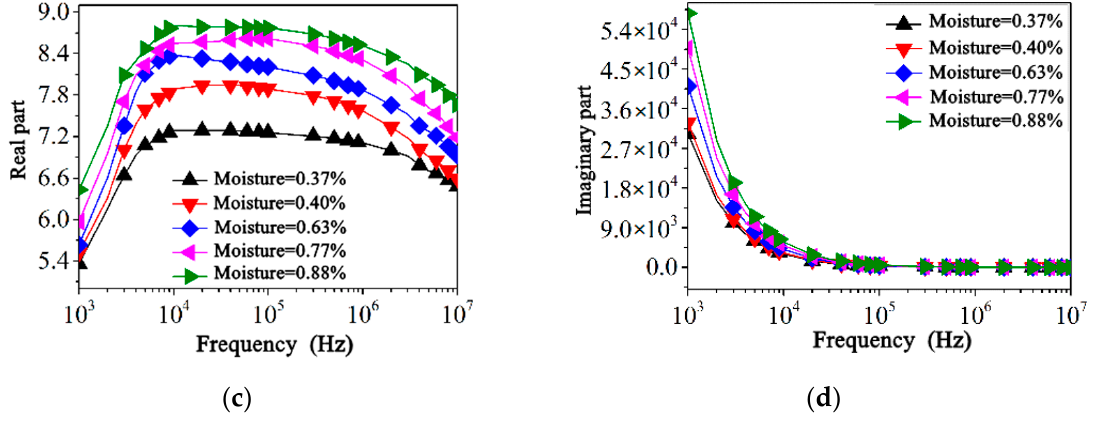
Figure 3. Complex permittivity FDS of oil-immersed insulating and semi-conductive paper: ( a ) oil-immersed insulation paper real part; ( b ) imaginary part of oil-impregnated insulating paper; ( c ) semi-conductive paper real part; ( d ) semi-conductive paper imaginary part.